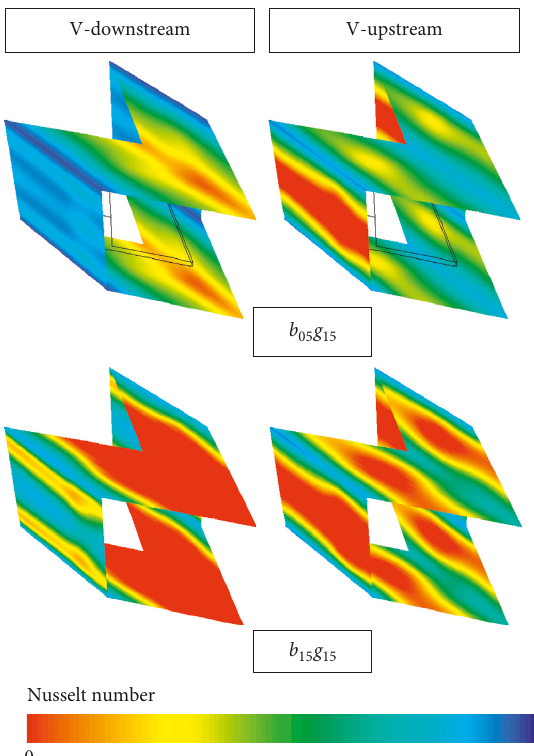
Figure 10: Local Nusselt number distribution on the channel walls for the square channel heat exchanger installed with V-orifice at various blockage ratios and flow direction for Re 600 and V-downstream (cid:31)